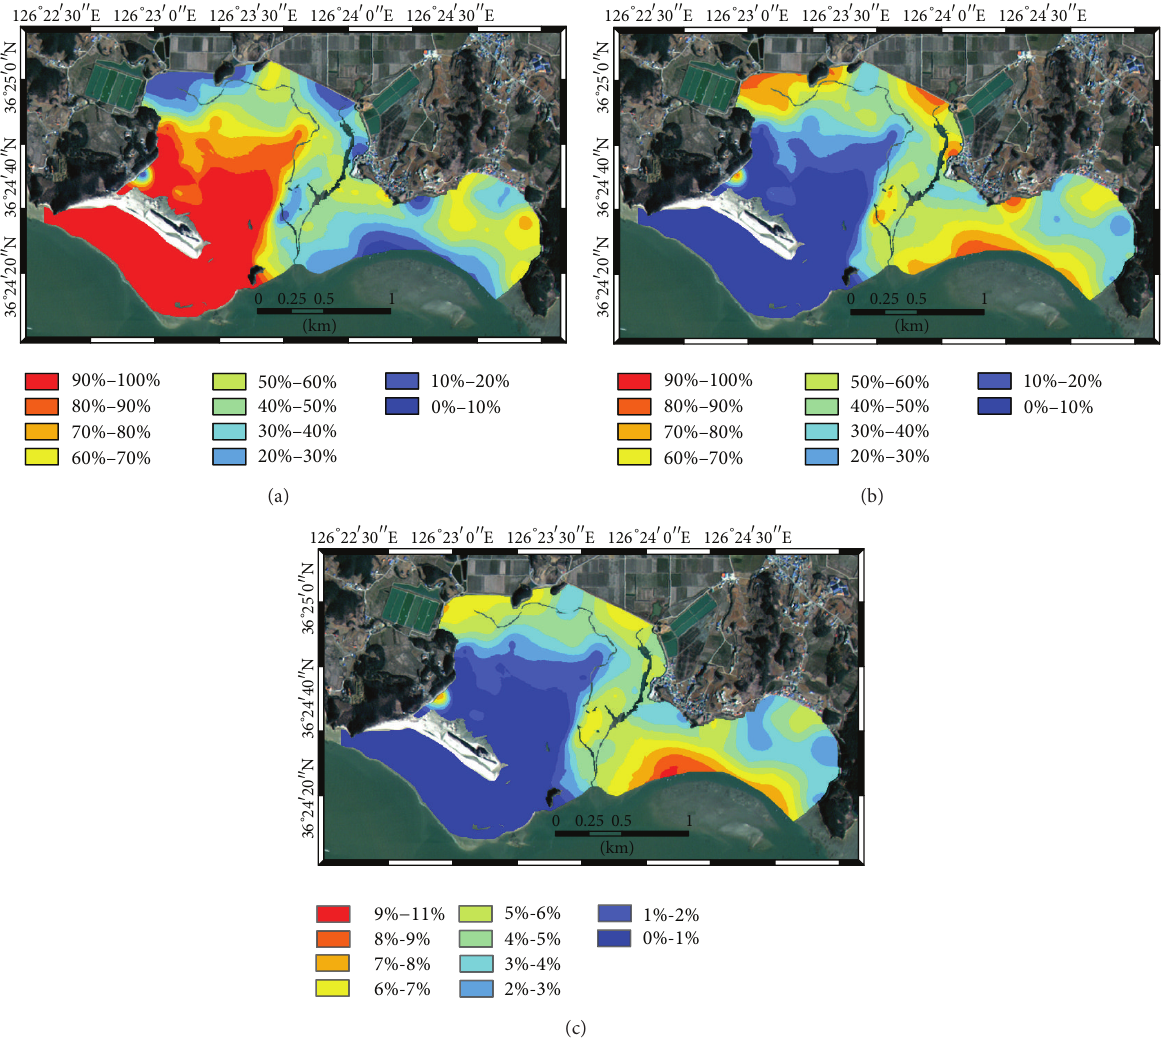
Figure 7: Spatial distributions of fractions generated by cokriging of alr transformed variables: (a) sand, (b) silt, and (c) clay.